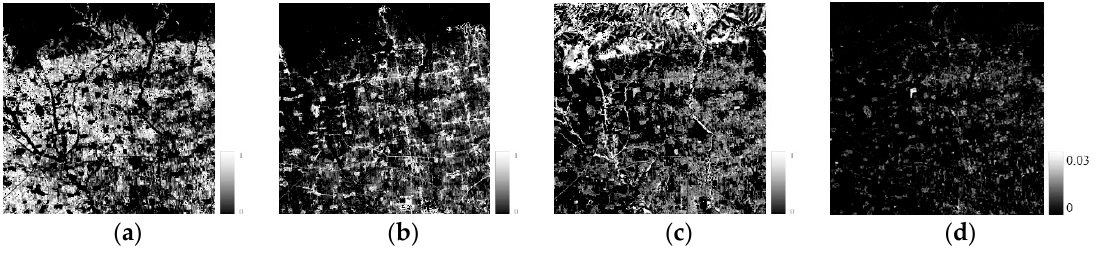
( d ) RMSE. Sensors 2019 , 19 , x RMSE.